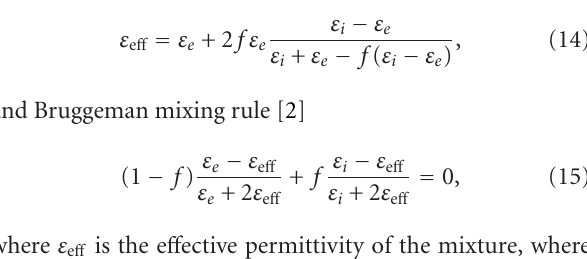
Figure 14: Mixing rules and FDTD simulation results of material